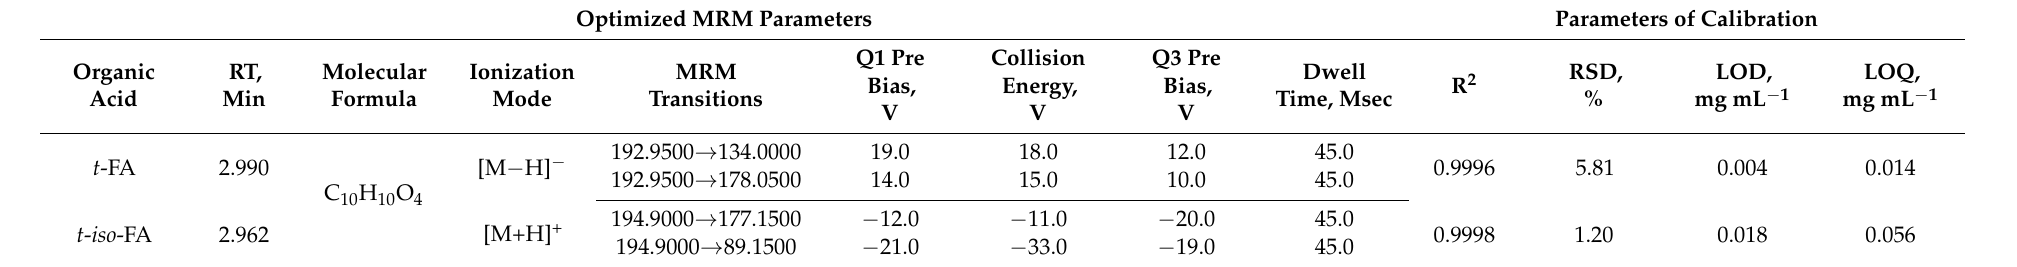
Table 3. The MRM transitions and corresponding collision energy, Q1, Q3 and dwell time for investigated rye bran-derived bioactives. Optimized MRM Parameters Parameters of